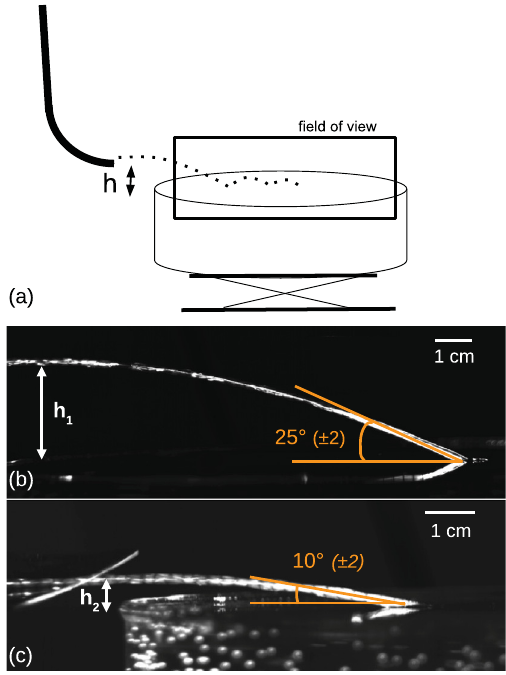
Fig. 3. (a) Diagram showing the fi eld of view corresponding to the following images. (b, c) Trajectory of drops for two different heights of the slide: h 1 =2.6 cm and h 2 =0.7 cm. We observed a smaller impact angle for h 2 (10 ±2 ° ) than for h 1 (25 ±2 ° ). Both images are obtained from successive frames (300fps) layered in a single one to reconstruct the full trajectory.